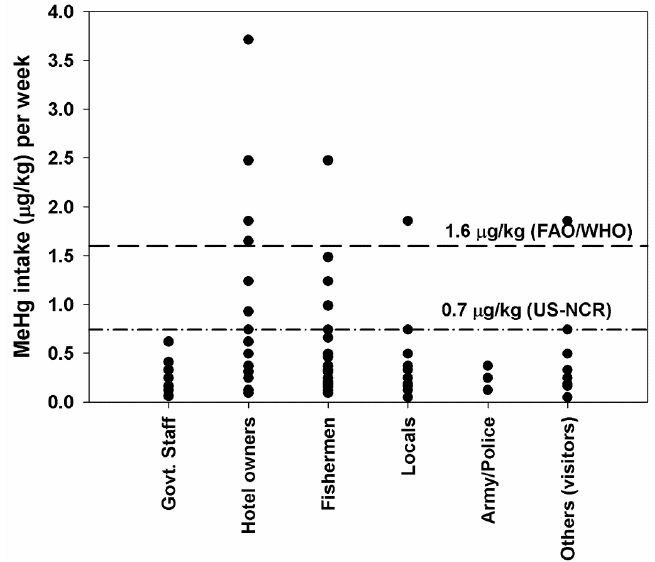
Figure 2. Risk of MeHg intake by individuals based on their fish consumption habits from Lake